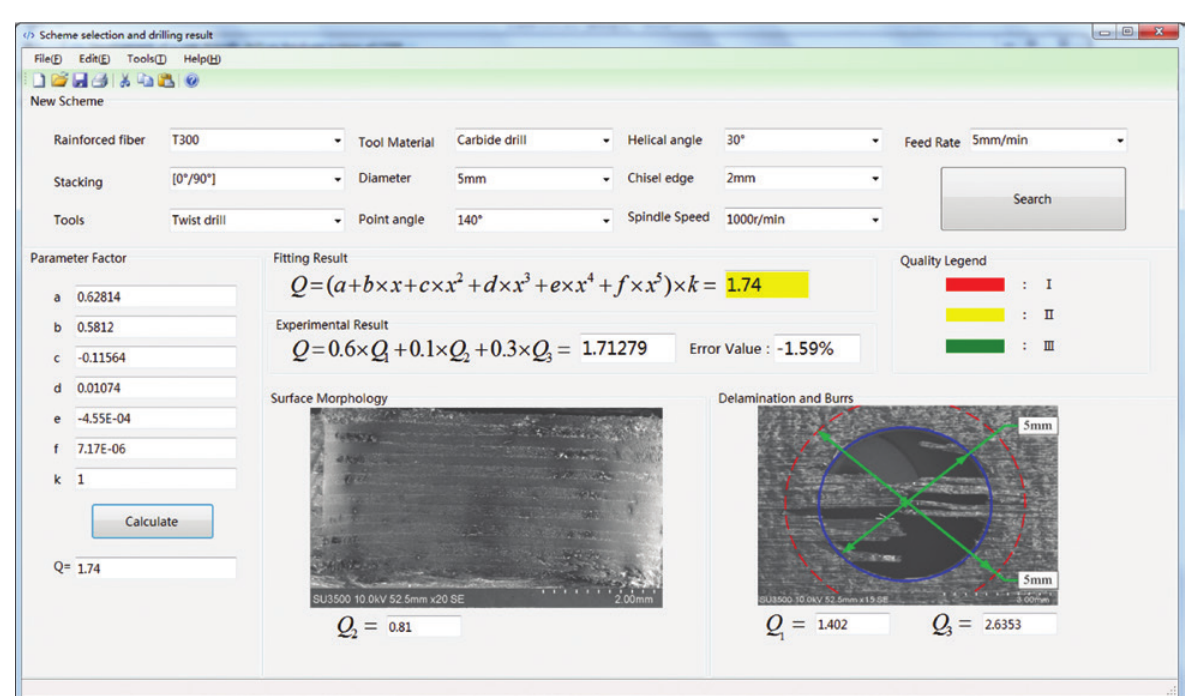
Figure 9: Scheme selection and drilling result